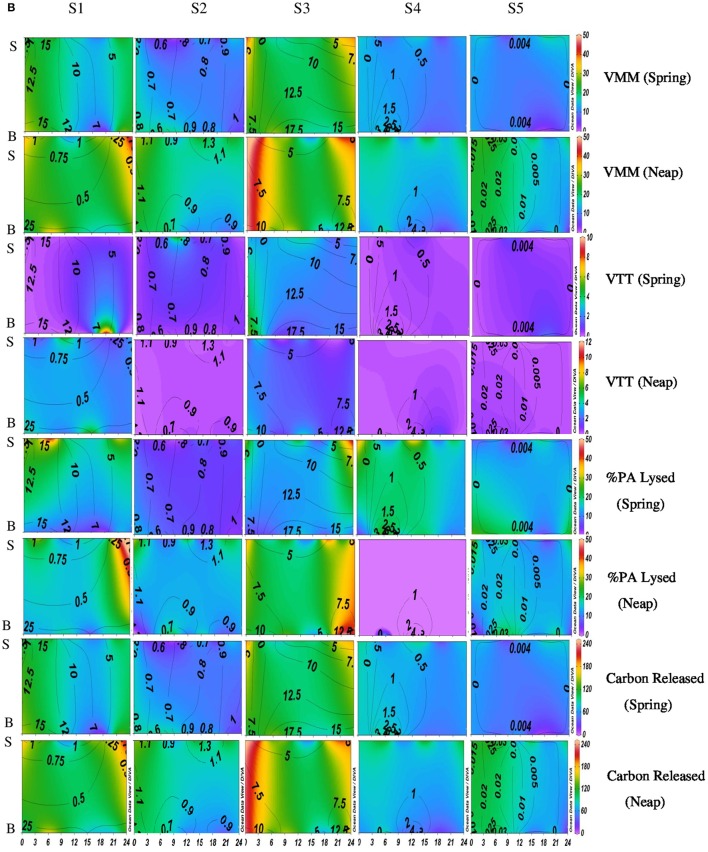
Temporal variations (diel and tidal) in biological parameters during monsoon (MON) in CE. X- axis represents the time series observations from 00:00 to 24:00 h and Y-axis represent the vertical section of the water column (S, Surface; B, Bottom). Z-axis represent different parameters in color contours and salinity is superimposed as the line contours. The vertical panels S1, S2, S3, S4, and S5 represents the five stations. The horizontal panels represent various parameters during MON, such as, Viral-mediated mortality (VMM%), Viral turnover time (VTT) (d−1), % of BA lysed, and Carbon released (μg/C/L/day) during spring and neap phases separately.